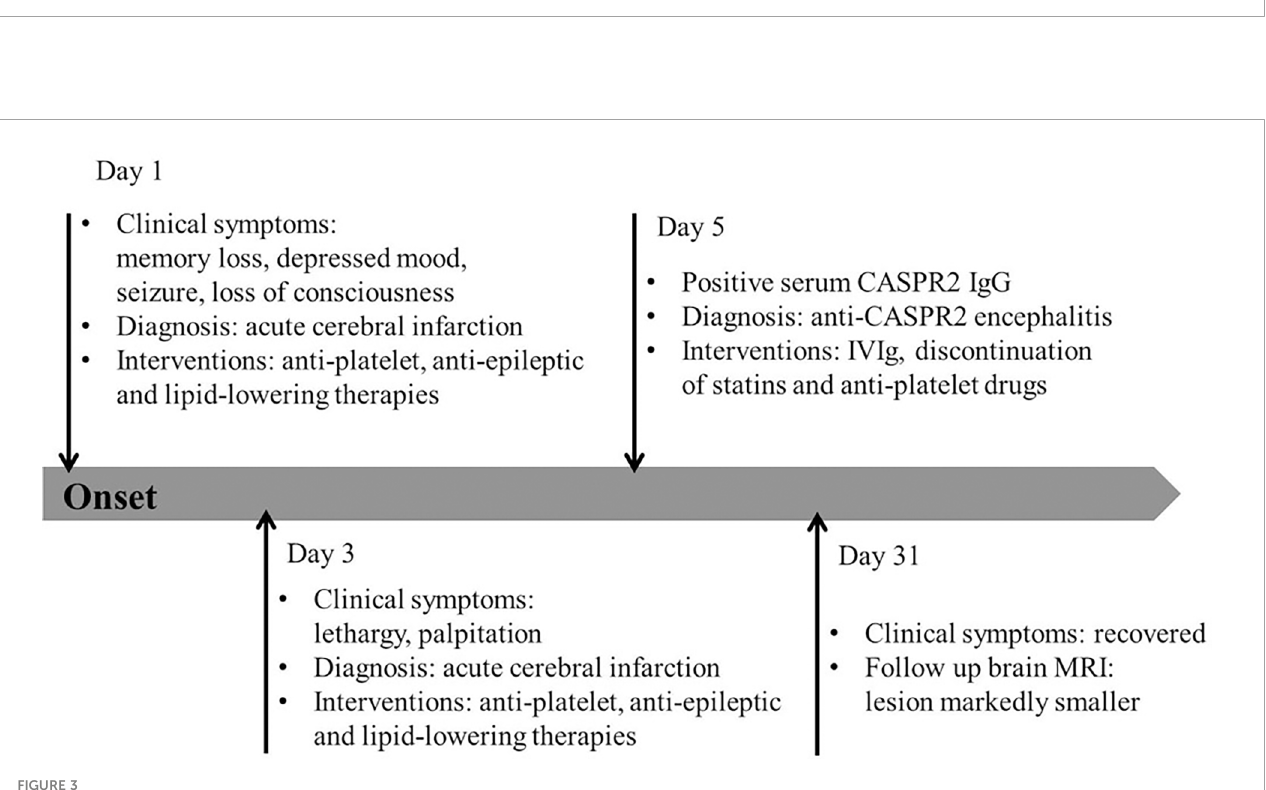
FIGURE 3 Timeline of the patient ’ s episodes and interventions. Day 1 refers to the day of admission to our emergency department. CASPR2, contactin-associated protein-like 2; IVIg, intravenous